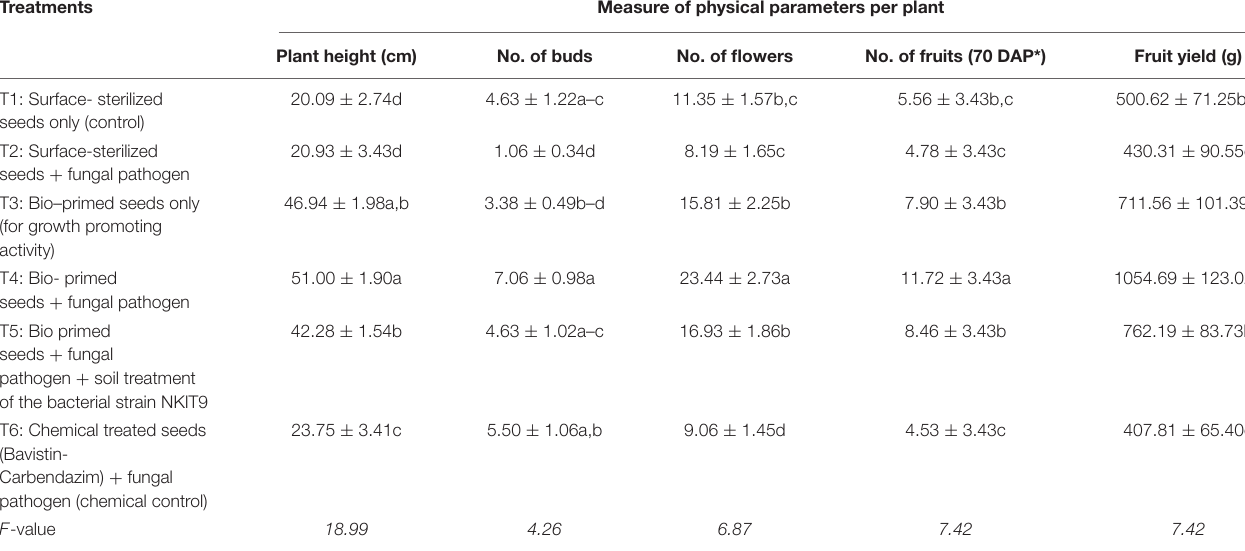
TABLE 4 | Morphological characters and fruit yield of tomato crops observed with different treatments. Treatments Measure of physical parameters per plant